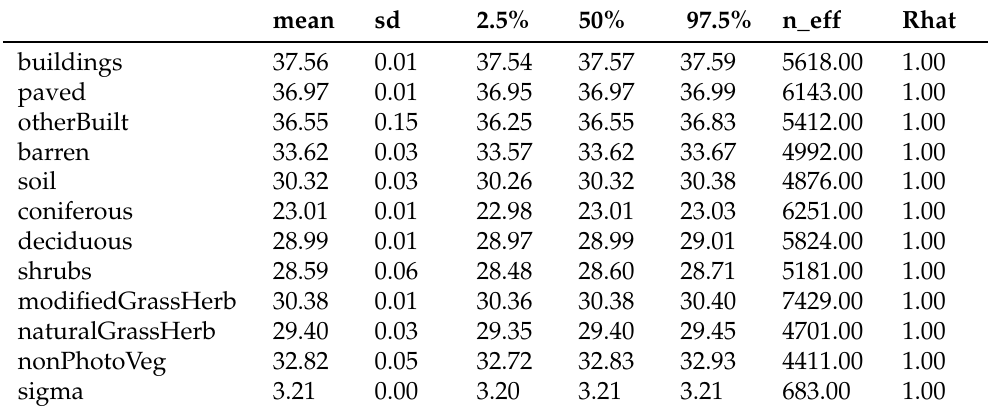
Table A2. Summary of model on effects of land cover class on surface temperature.